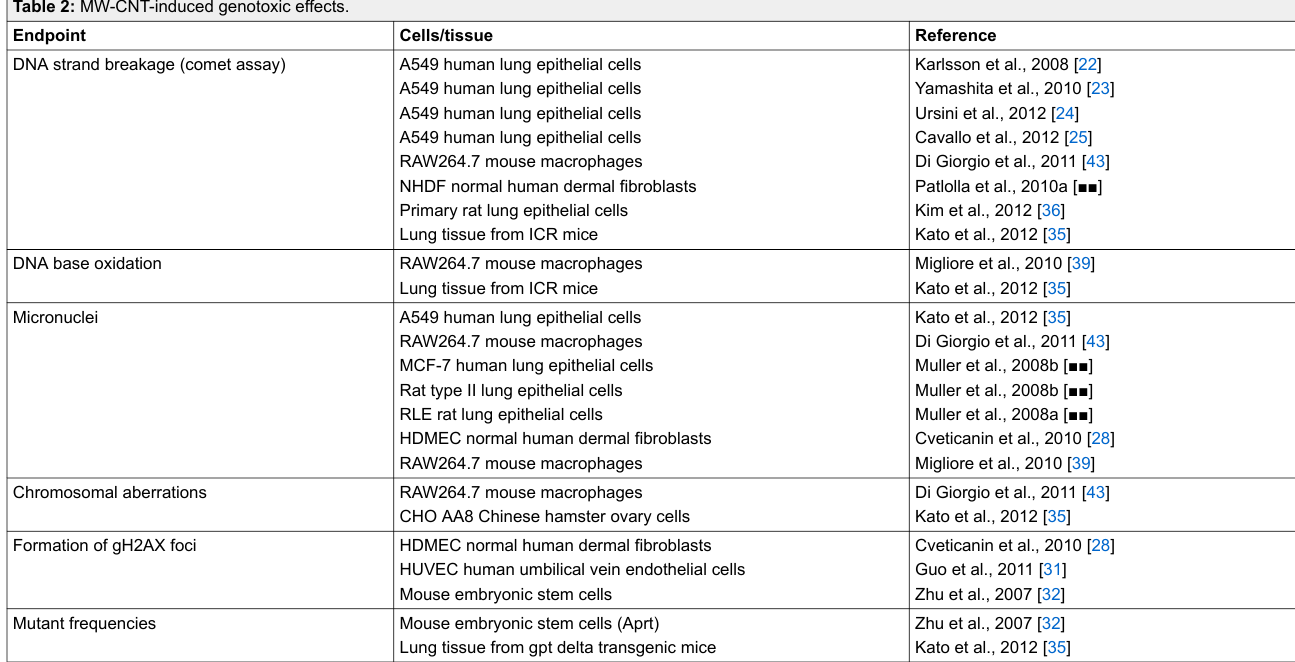
Table 2: MW-CNT-induced genotoxic